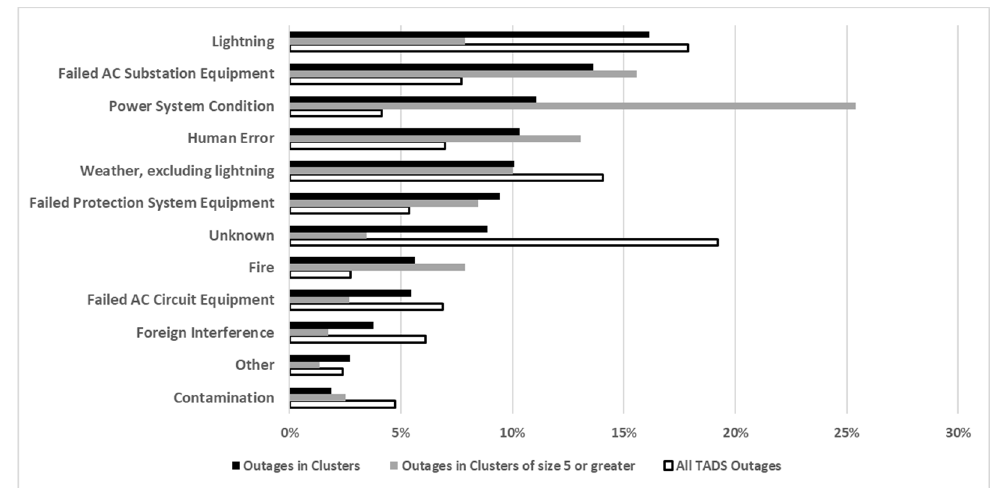
Figure 3. Comparative breakdown of outages by initiating cause (2013–2019).